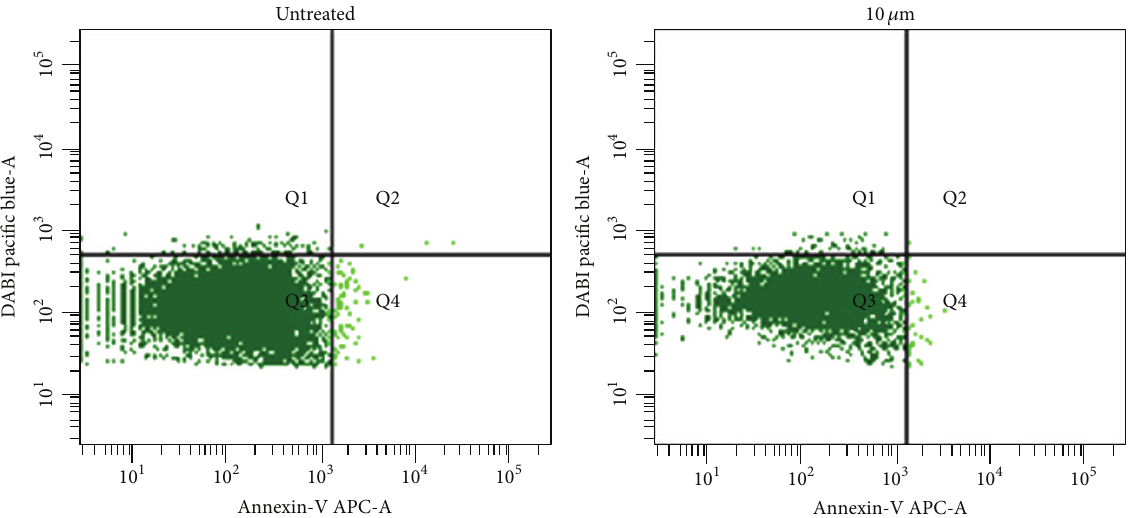
Figure 4: Measurement of annexin-V binding by flow cytometry. Apoptotic effects of compound 13 against noncancerous human breast epithelial cell line MCF10A showed no effect between the treated (10 𝜇 M) and the untreated